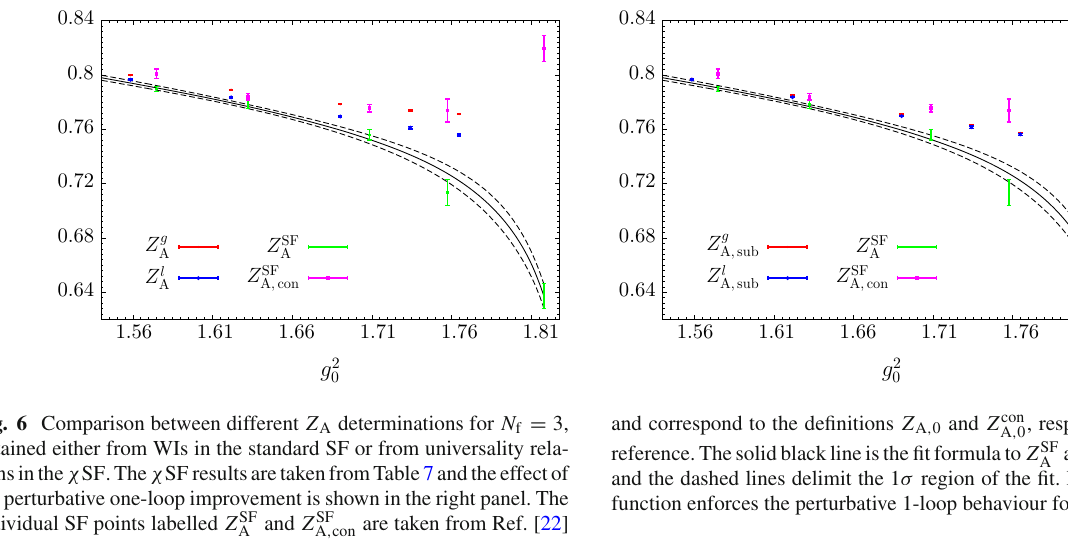
correspond to linear fits to the data constrained to extrapolate to 1 for a / L 1 , 2 = 0. Note that the (tiny) effect of the statistical correlation between numerator and denominator has been neglected in these